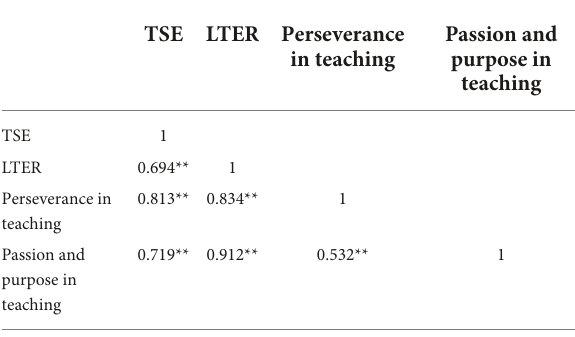
TABLE 5 The correlation coefficients among TSE, LTER, and L2G’